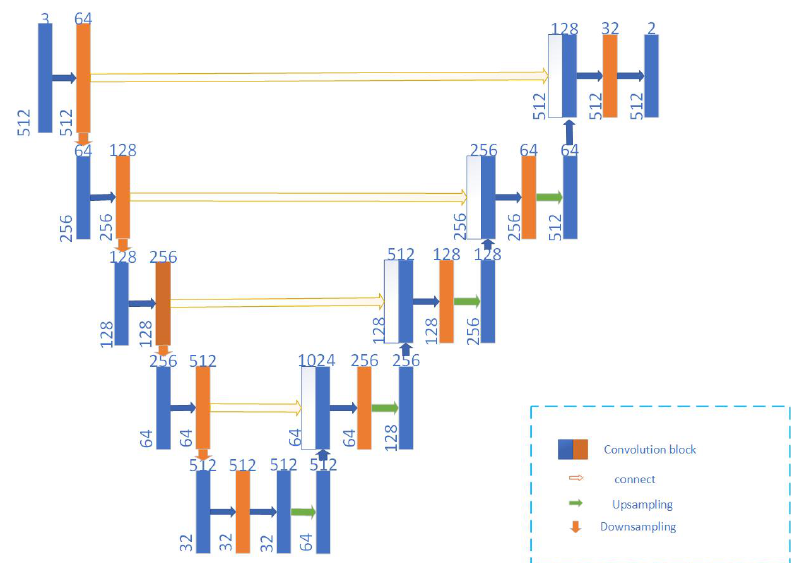
Figure 5. Unet network